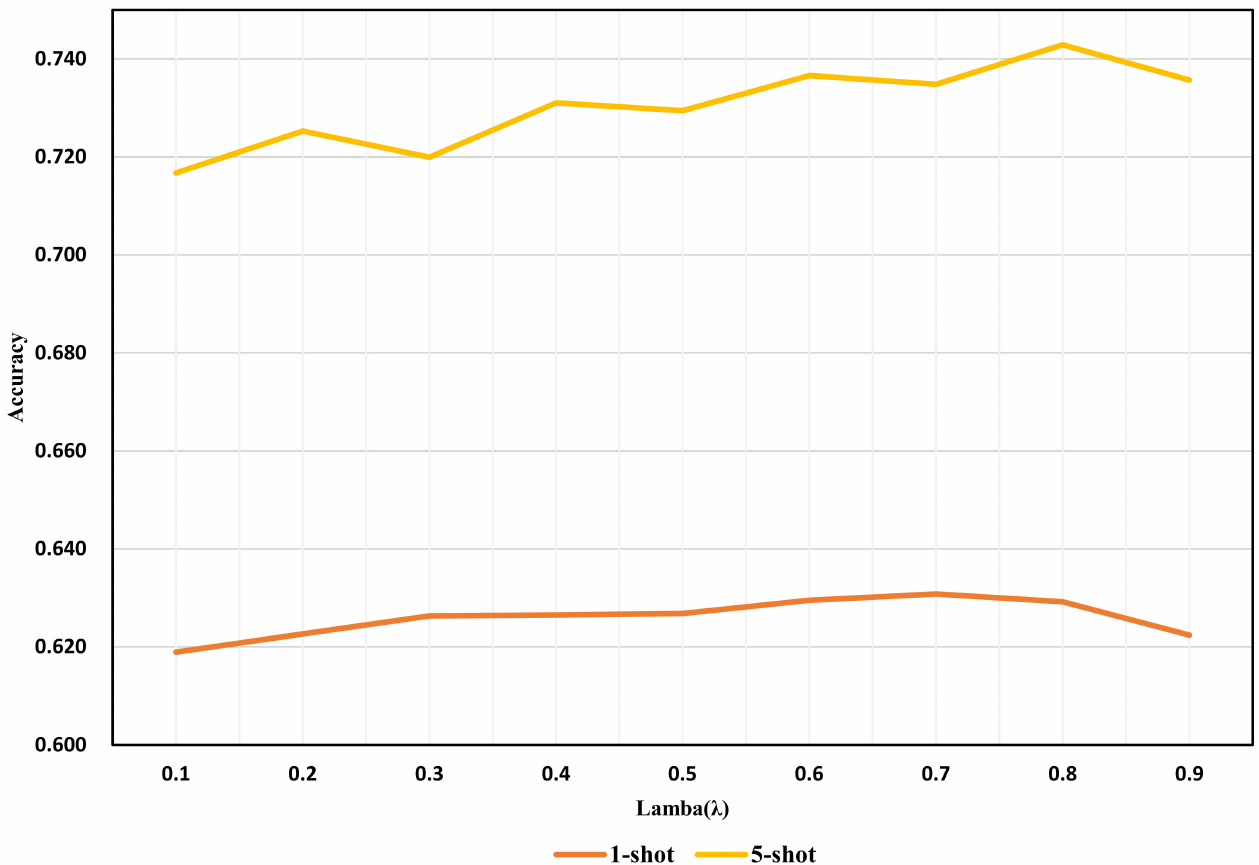
Figure 7. Model’s accuracy with different settings of hyperparametric λ in 1-shot and 5-shot scenarios. The x -axis shows the different values of λ , and the y -axis shows the model’s accuracy. The orange curve represents the classification accuracy of the 1-shot scenario. The model’s accuracy improves as the λ increases, reaching a maximum with λ of 0.7. However, the model’s accuracy starts to decrease with an excessively large λ . The yellow curve represents the classification accuracy of the 5-shot scenario. Similarly, the model’s accuracy improves as the λ increases, reaching a maximum with λ of 0.8. However, the model’s accuracy starts to decrease with an excessively large λ